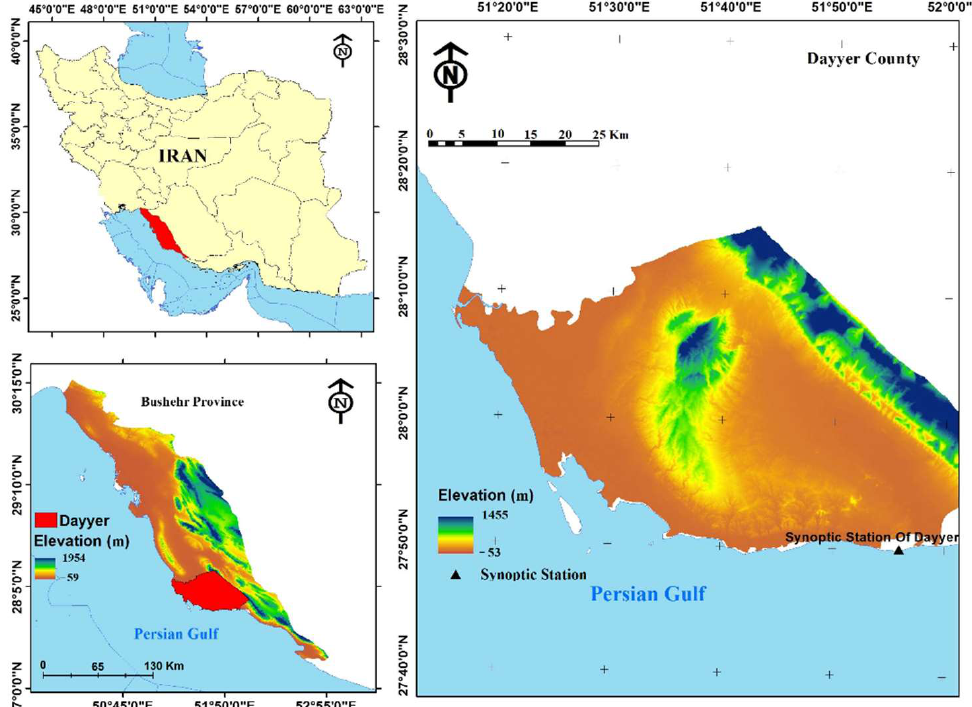
Figure 1. Location of Bushehr Province in Iran ( top left panel ) and Dayyer County in Bushehr Province ( bottom left panel ), supplemented by the map presenting the elevation of the study area ( right panel ). Location of the Dayyer synoptic station is indicated by the black triangle.